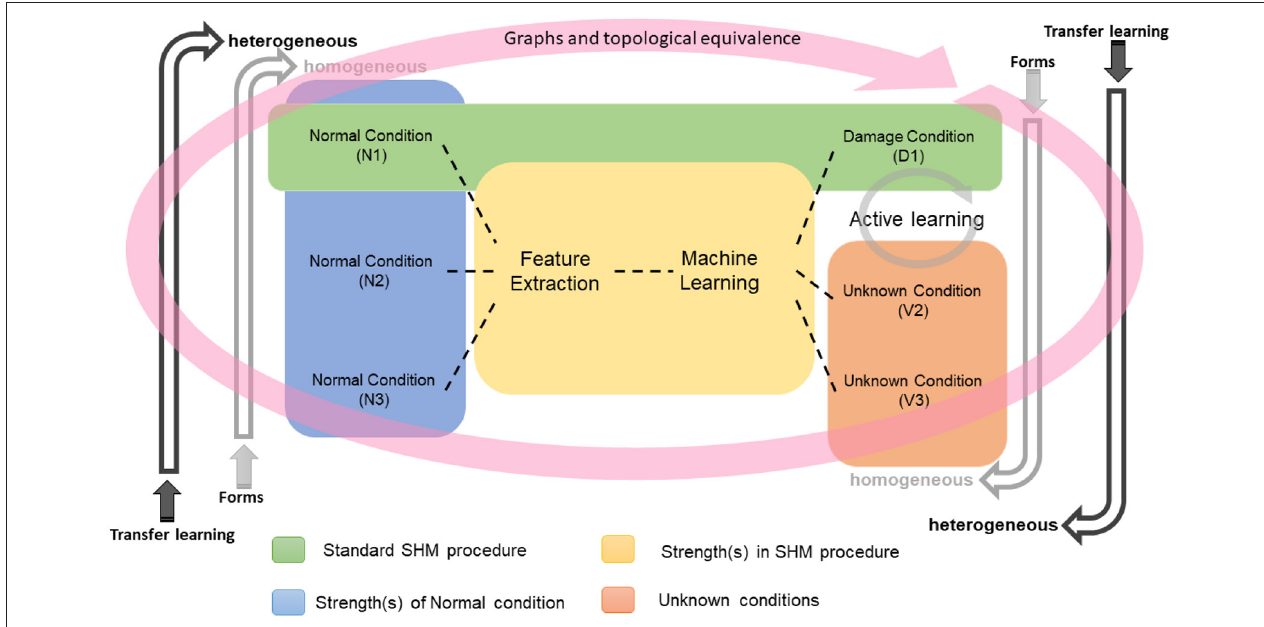
FIGURE 12 | Population-based SHM